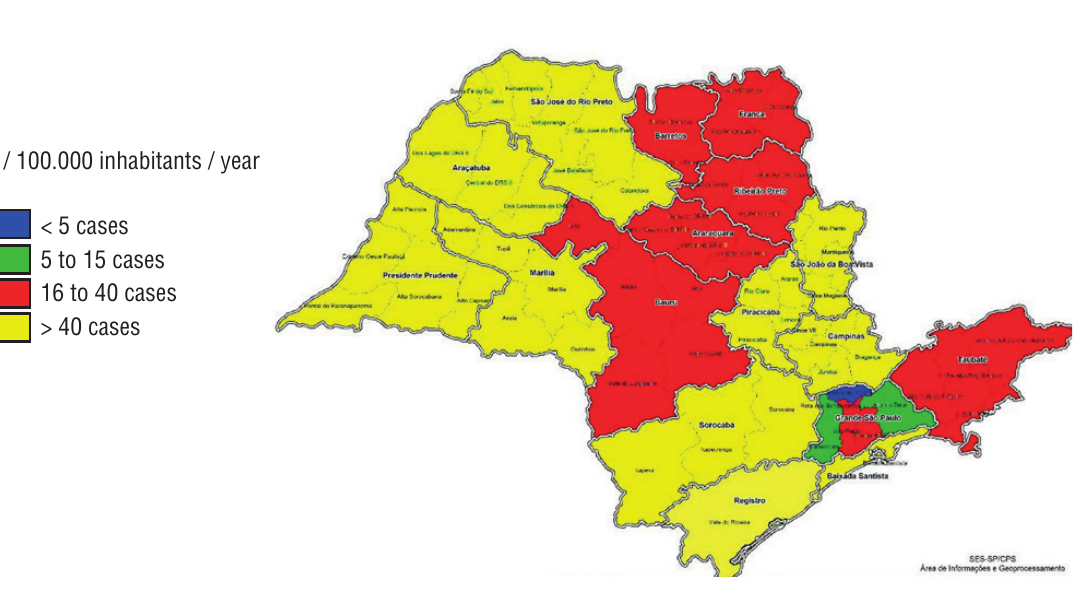
figure 5 - Map with the areas with high hospitalization rates (Sp).